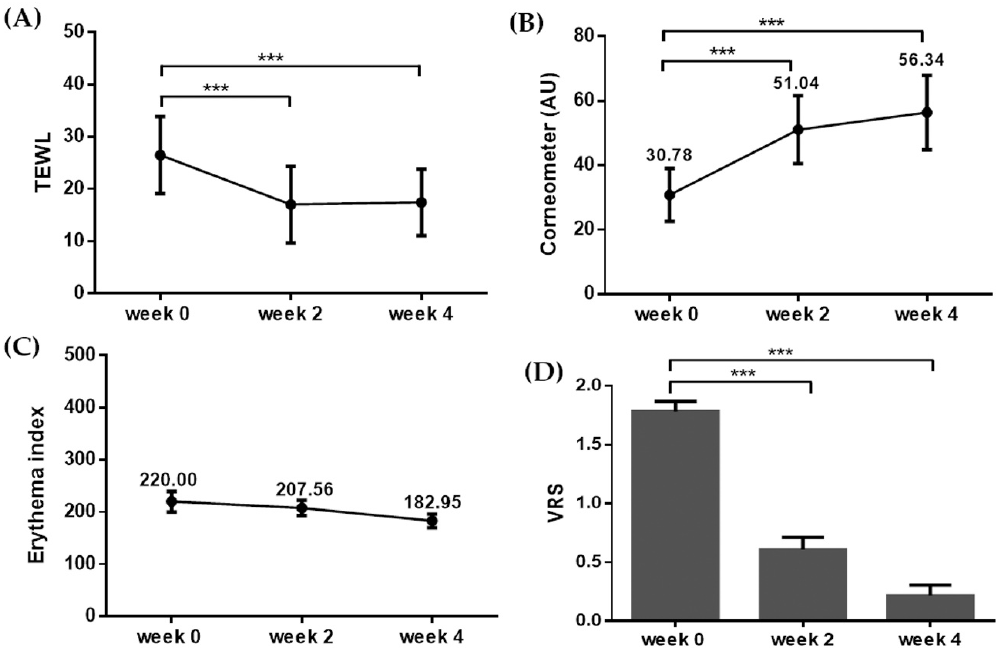
Figure 1. Changes in the biophysical parameters and itching after four-week application of the H.ECM TM liposome- containing emollient. The evaluations for ( A ) transepidermal water loss (TEWL), ( B ) skin hydration (using Corneometer), ( C ) erythema index, and ( D ) VRS (verbal rating scale) showed improvements after the application of the H.ECM TM liposome-containing emollient. *** p < 0.005.